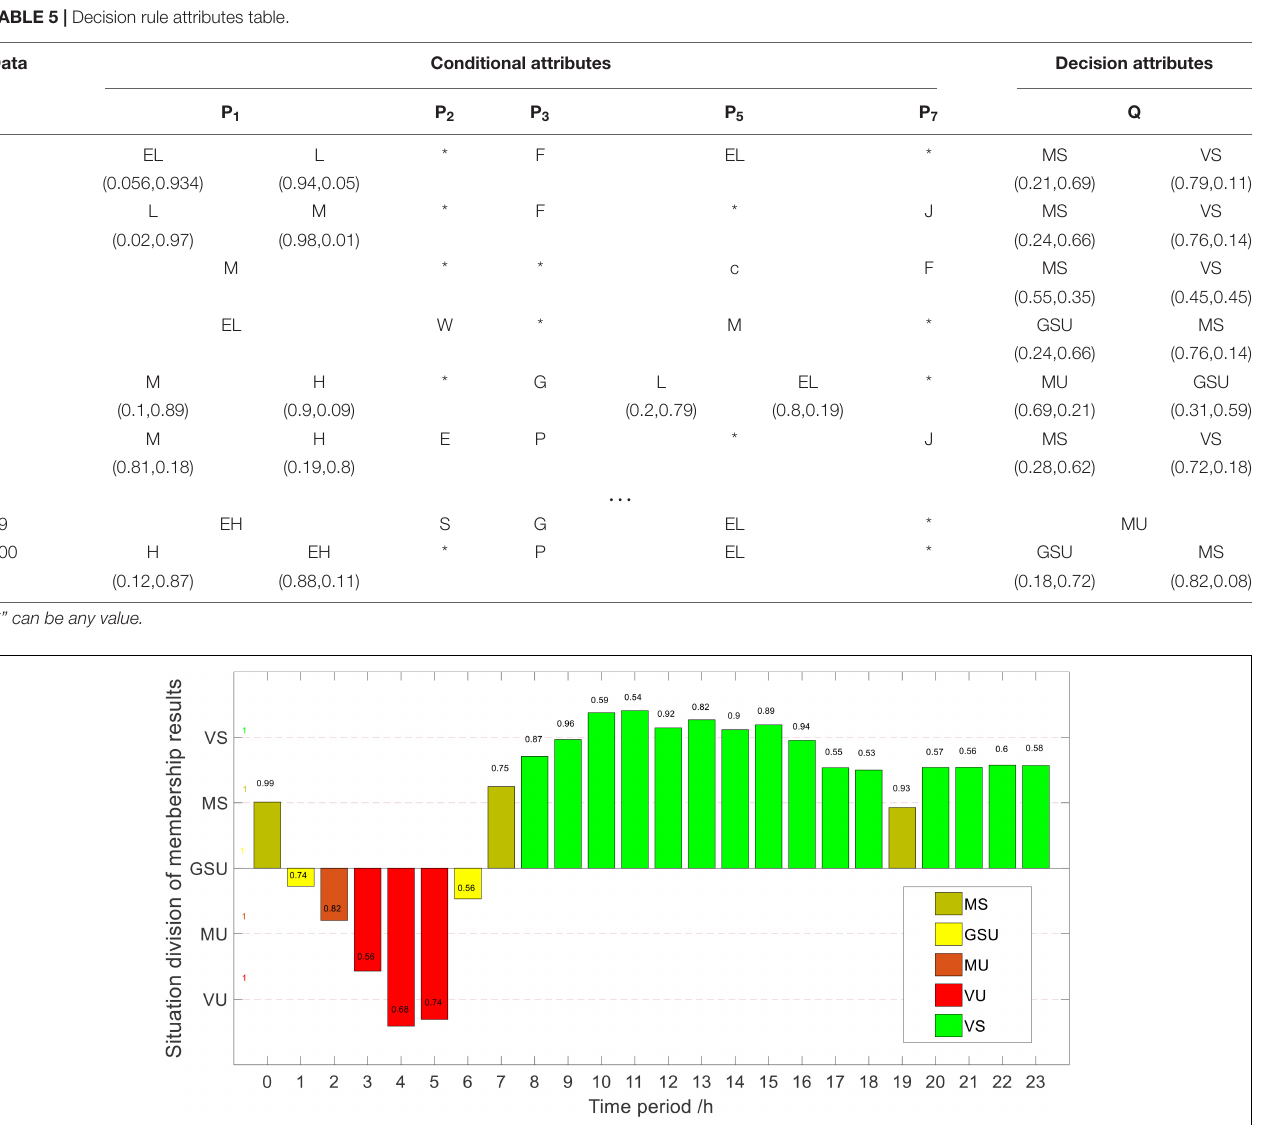
FIGURE 11 | The division result of consumption states of the electricity heat hydrogen system (EHHS) in mode